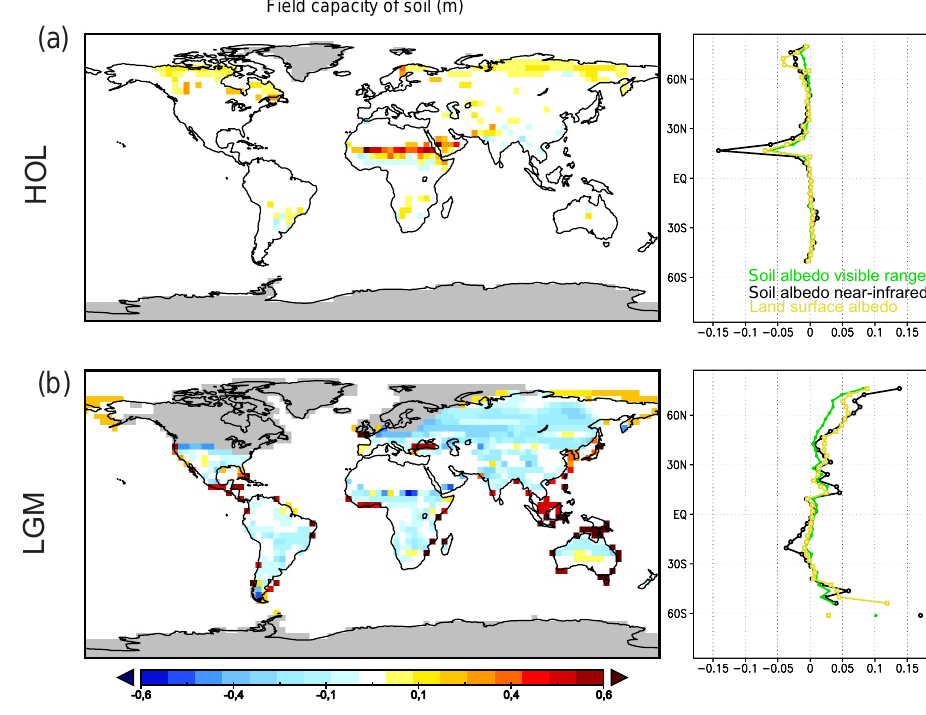
Figure 8. Changes in water-holding field capacities (metres) in soils and zonally averaged land surface albedo and soil albedo for (a) mid-Holocene (HOL_sol – PI_sol) and (b) Last Glacial Maximum (LGM_sol – PI_sol).